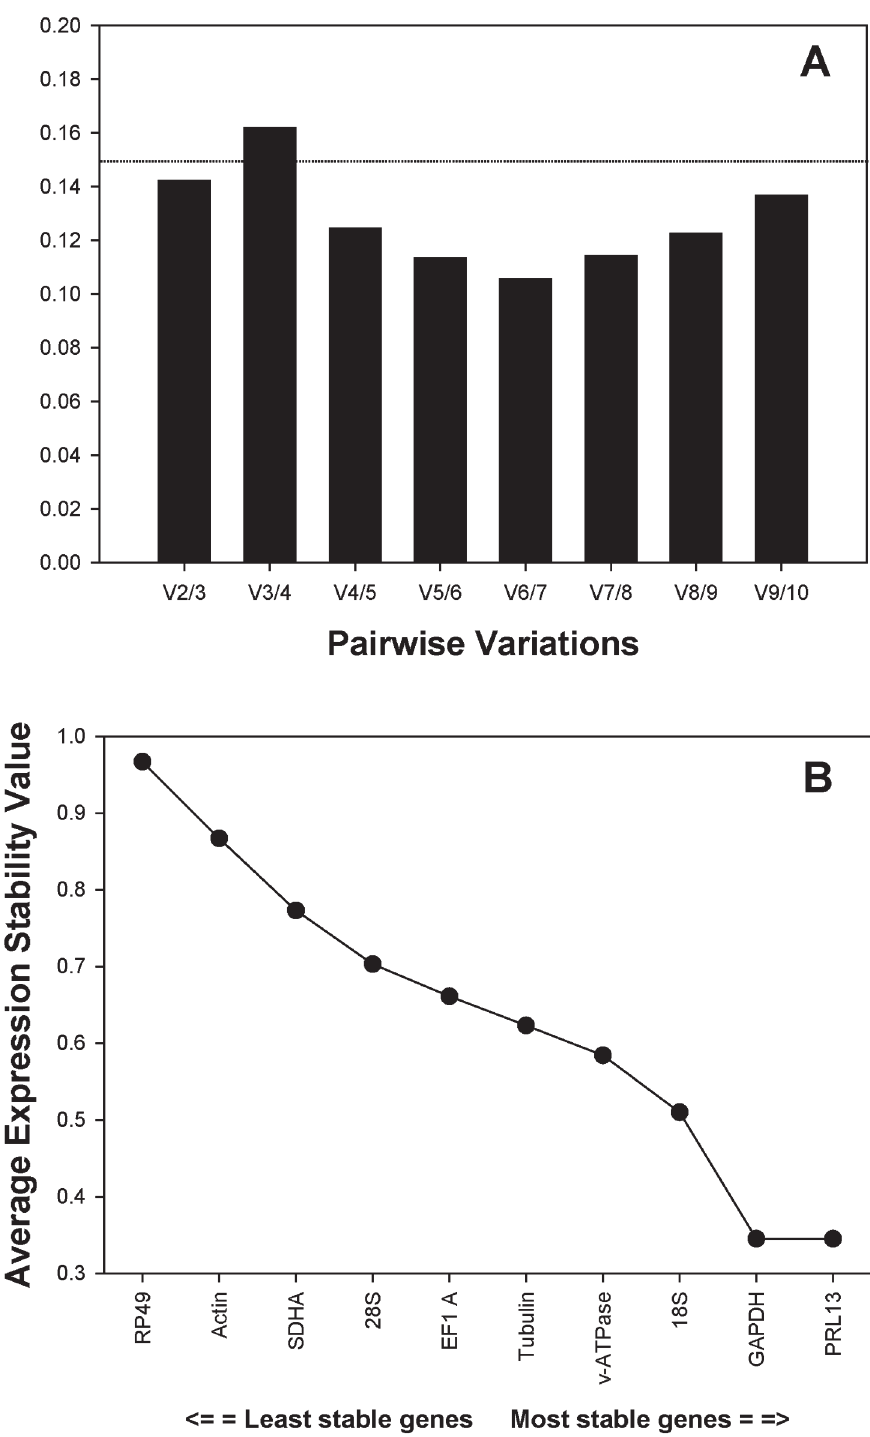
Fig 2. Quantitative and qualitative analyses based on geNorm . A) Pairwise variation (V) analysis. geNorm first calculates an expression stability value (M) for each gene and then compares the pair-wise variation (V) of this gene with the others. The pair-wise variation (V n /V n+1 ) was analyzed between the normalization factors NF n and NF n+1 by the geNorm software to determine the optimal number of references genes required for normalization. A threshold of V < 0.15 was suggested for the valid normalization [1]. B) Ranking of the 11 housekeeping genes based on the stability value